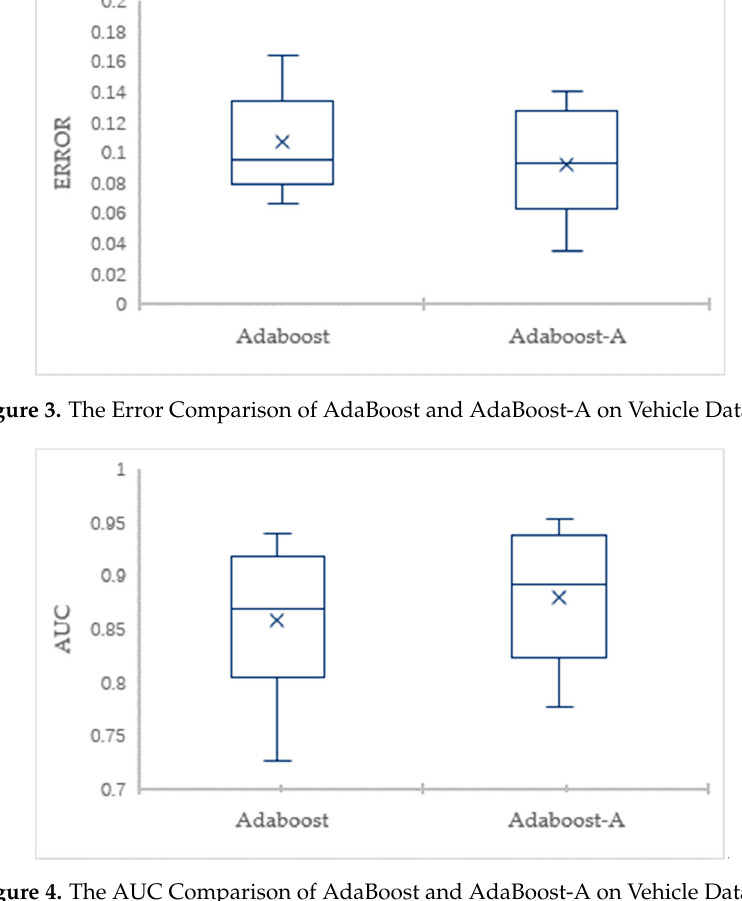
Figure 4. The AUC Comparison of AdaBoost and AdaBoost-A on Vehicle Dataset.